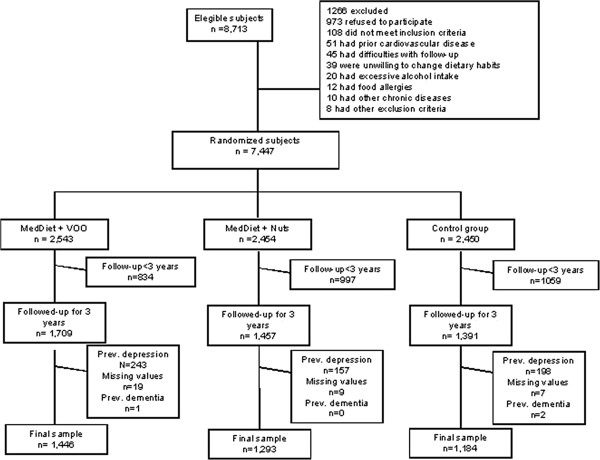
Profile of the PREDIMED (Prevención con Dieta Mediterránea) field trial.